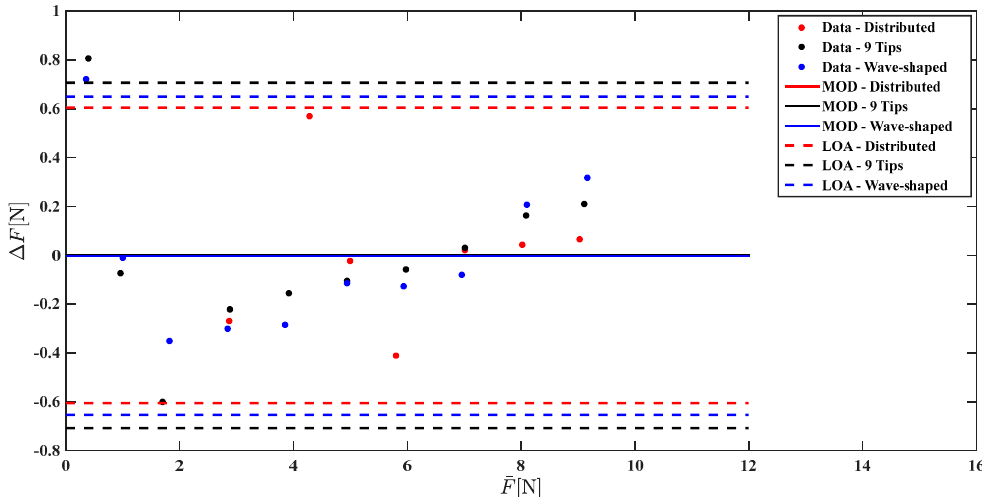
Figure 10. Bland Altman analysis comparing F c with F r for the three loading conditions (results obtained with the Distributed load, with the 9 Tips load and with the Wave-shaped load are shown in red, in black and in blue, respectively).